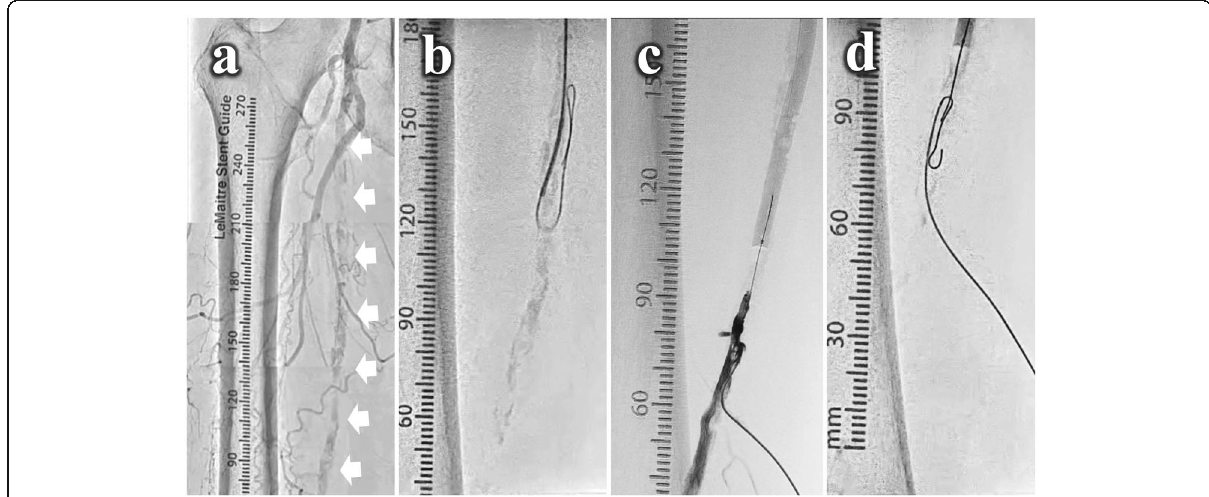
Fig. 1 Angiography and the conventional bi-directional approach. A . Control angiography showed the overall lesion (white arrows). B . A 0.035-in. guidewire was antegradely advanced into the subintimal plane to perform percutaneous intentional extraluminal recanalization (PIER) technique, but antegrade re-entry wiring failed. C . The distal SFA was punctured with 20-gauge needle, and 0.018-in. guidewire with a microcatheter was inserted to establish a retrograde fashion, and the distal lumen was revealed by tip injection through the retrograde microcatheter. D . The retrograde wire could not be advanced into the occlusion due to the severely calcified